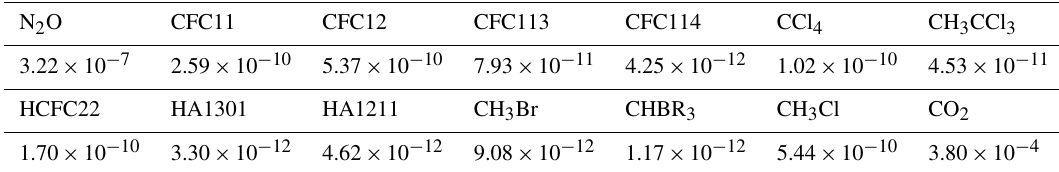
Table 1. Trace gases relevant for the stratosphere which are constrained at the surface. The constant surface volume mixing ratios are also